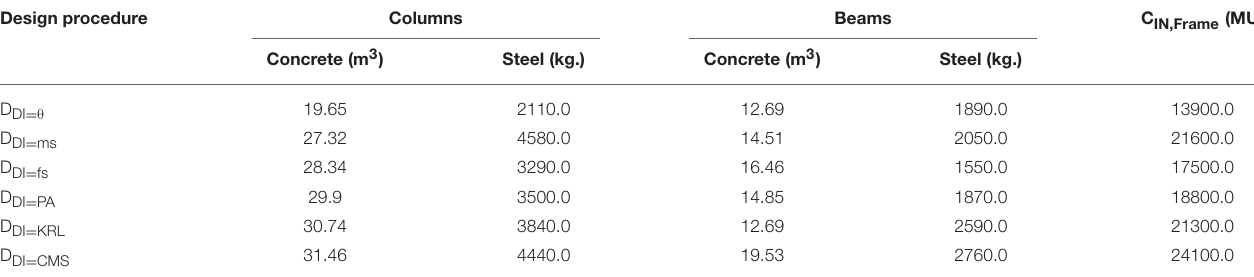
TABLE 4 | Six-story test example: Concrete volume and steel weight corresponding to the optimized designs based on six DIs. Design